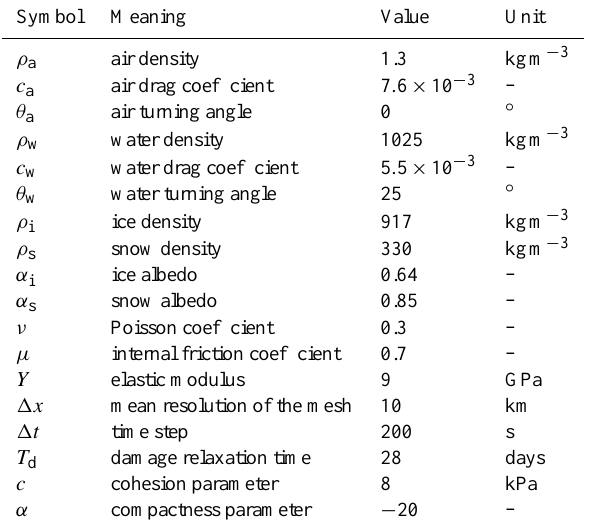
Table 2. Parameters used in the model with their values for the sim- ulations performed for this study.